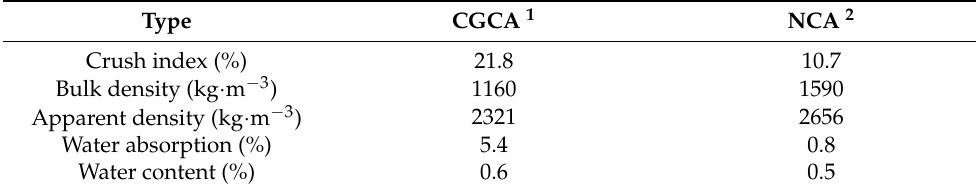
Figure 1. Coal gangue coarse aggregate (CGCA). Table 1. Properties of aggregates.